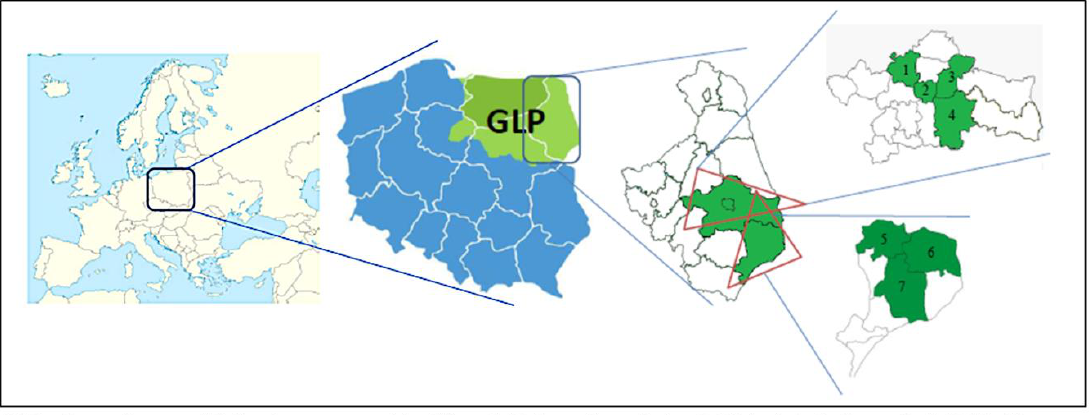
Figure 1. Location of the sampling area.